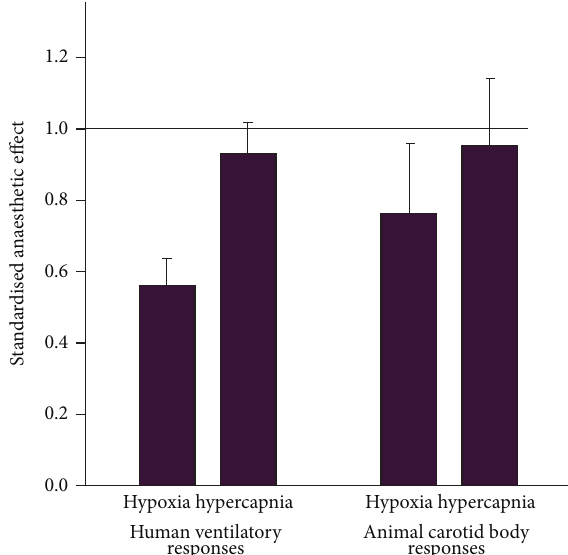
Figure 3: The mean effect of low dose ( < 0.2 MAC) anaesthetics on hypoxic and hypercapnic ventilatory responses in humans (values taken from data presented in references [5, 13]) and the data for animal carotid bodies (from this study). The smaller the value for standardised anaesthetic effect, the greater the depressive action of anaesthetic. For both animal carotid body and human ventilation, anaesthetics significantly depress hypoxic but not hypercapnic response. The error bars represent 95% confidence intervals. The horizontal line represents the line of unity (i.e., no effect of